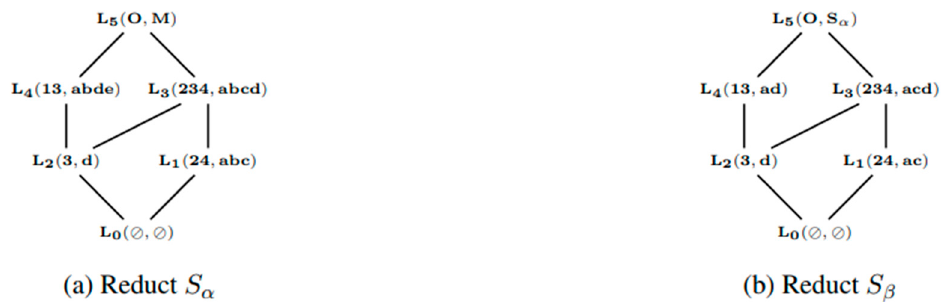
Figure 1. Object Ranking Concepts with Reduction.